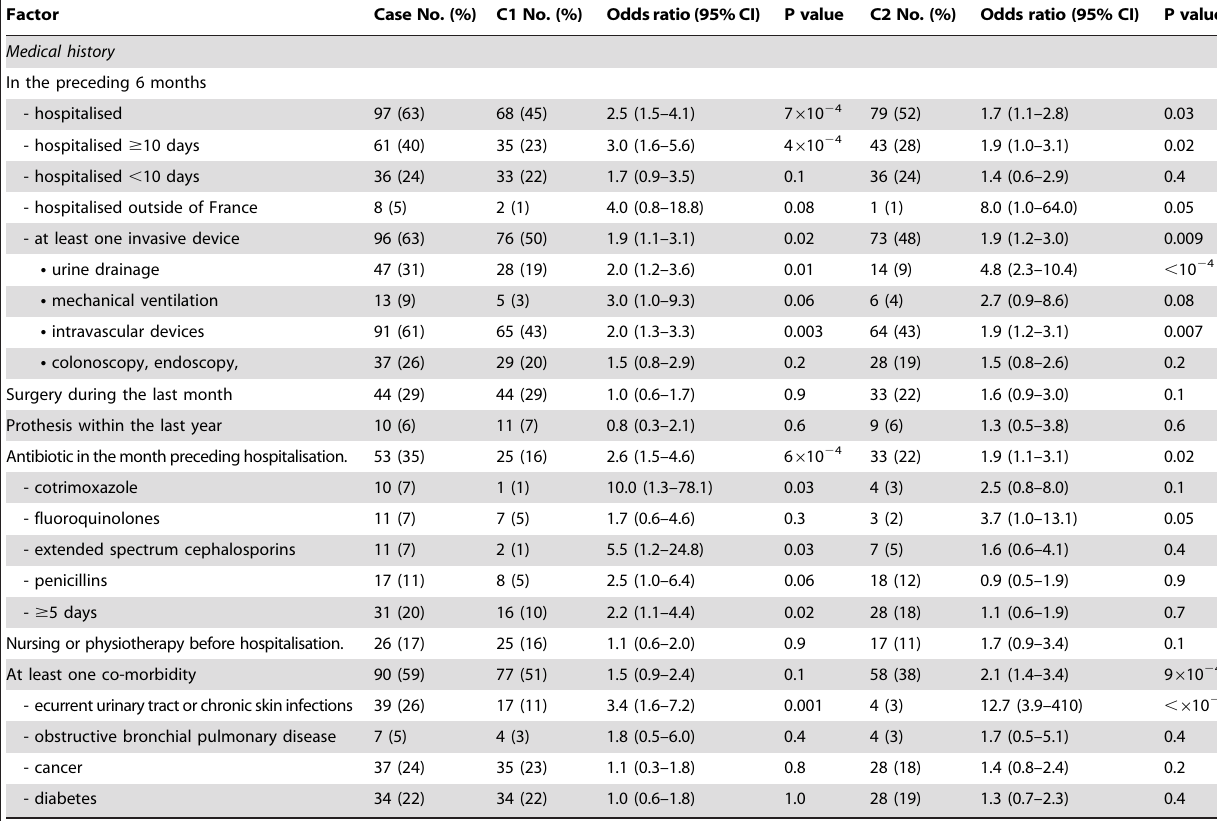
Table 2. Univariate analysis of medical history-related factors associated with a CTX-M-producing E. coli clinical isolate through a case (patient with a CTX-M producing E. coli isolate) - control (C1: patient with a non-ESBL-producing E. coli isolate) - control (C2: patient with negative clinical samples)